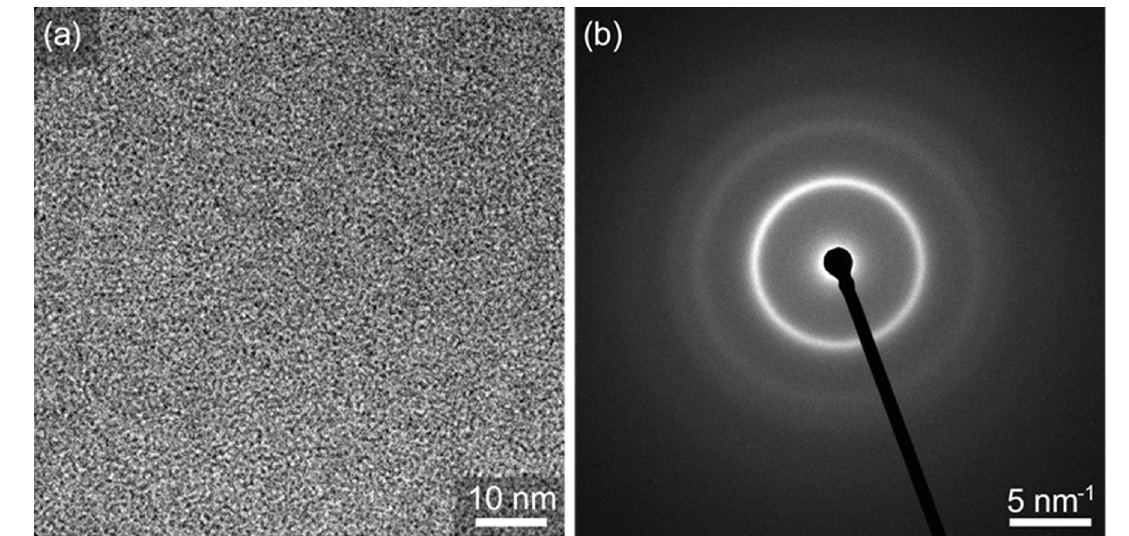
Figure 5. High-resolution TEM image of a FIB-lamellae ( a ) and the corresponding selected-area diffraction pattern ( b ) of alloy A (Fe 73.9 Cu 1 Nb 3 Si 15.5 B 6.6 ) deformed by HPT at 473 K for 10 turns.